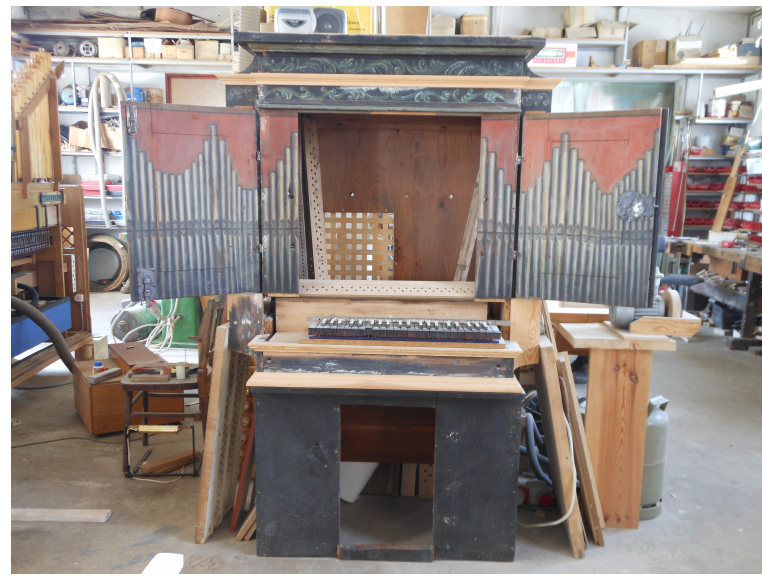
Figure 1. Open chest organ (pipes depicted on the